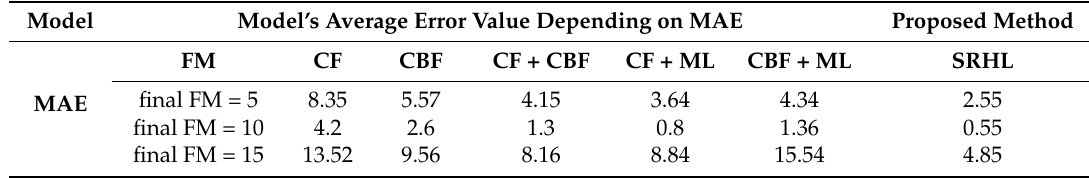
Table 8. Summary of average error value by MAE.